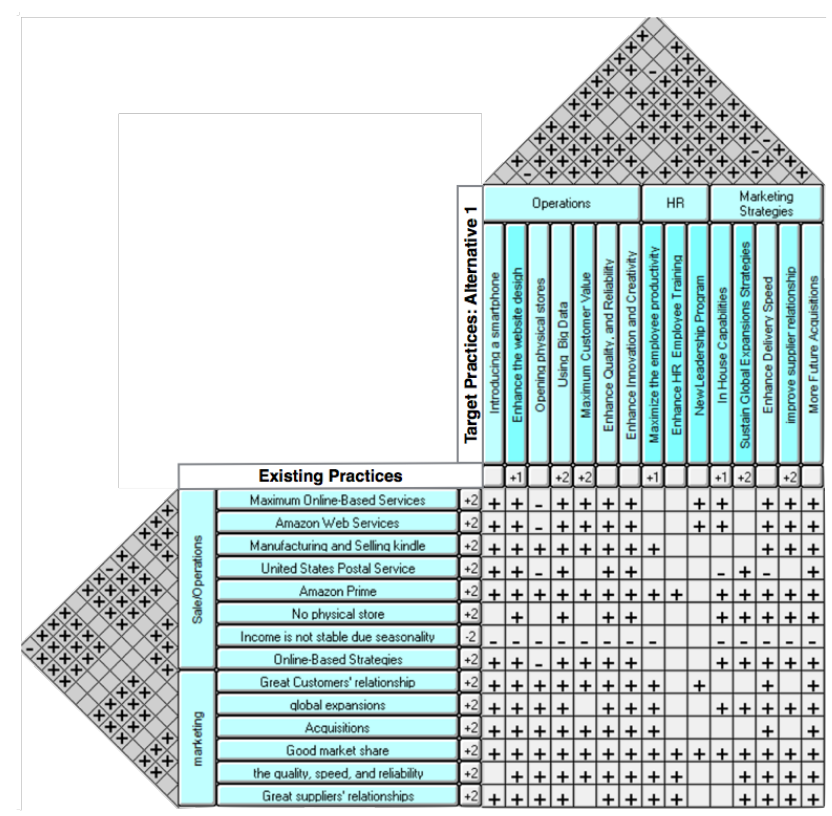
Fig. 11. Amazon Matrix of